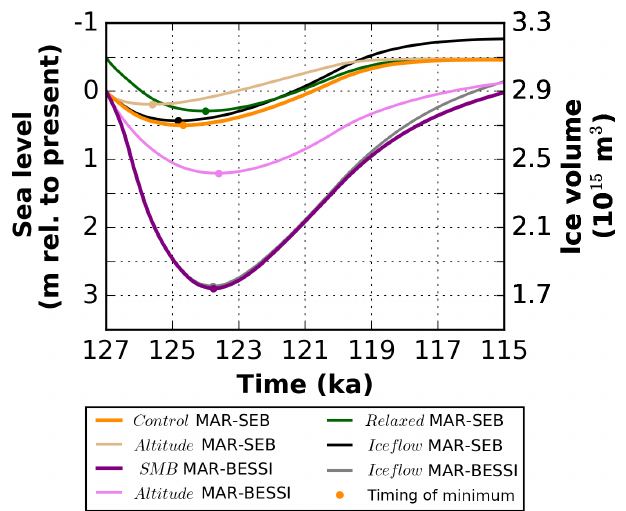
Figure 2. Evolution of the ice volume for the control (MAR- SEB, orange, bold) and the SMB experiments (MAR-BESSI, pur- ple, bold) in comparison with the altitude , relaxed , and ice flow sen- sitivity experiments. The corresponding altitude (no SMB–altitude feedback) and ice flow (2-D SSA) sensitivity experiments are shown in lighter colors and black/gray, respectively. The relaxed sensitiv- ity experiment (relaxed larger initial ice sheet but otherwise control forcing) is shown in dark